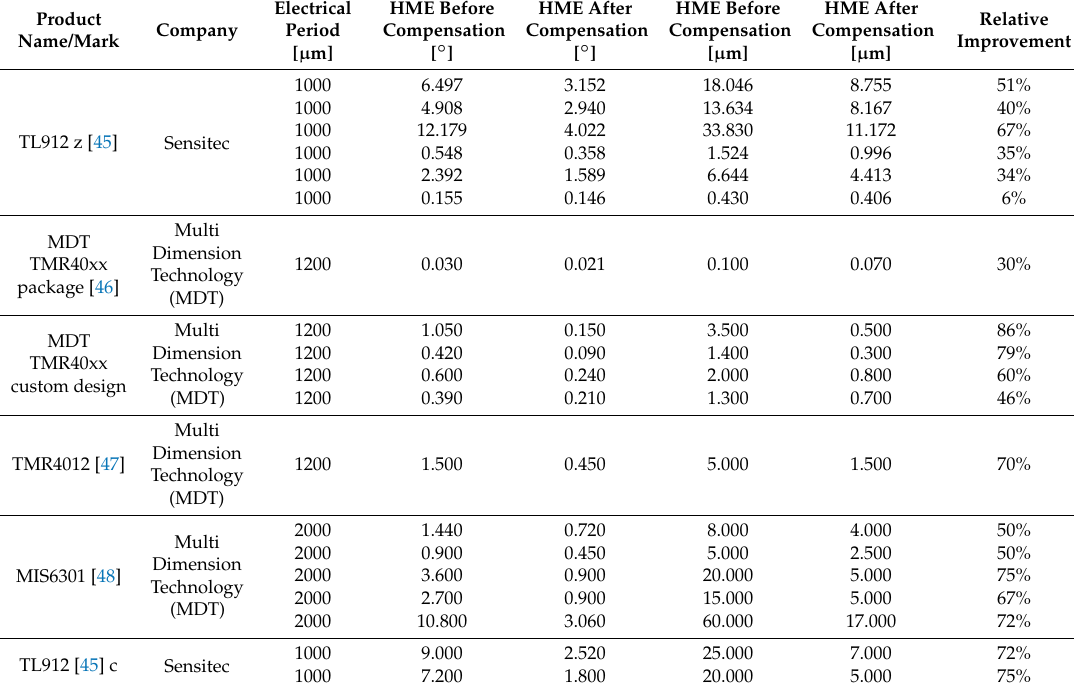
Table A2. The experimental data for TMR sensor